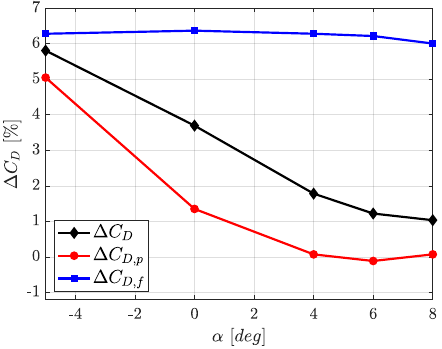
Figure 6. Riblets drag reduction vs. angle of attack for the UAV wing.